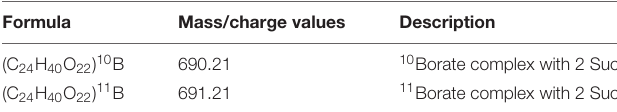
TABLE 1 | Mass/charge values of sucrose-borate complexes determined by the ESI-Q-TOF-MS. Formula Mass/charge